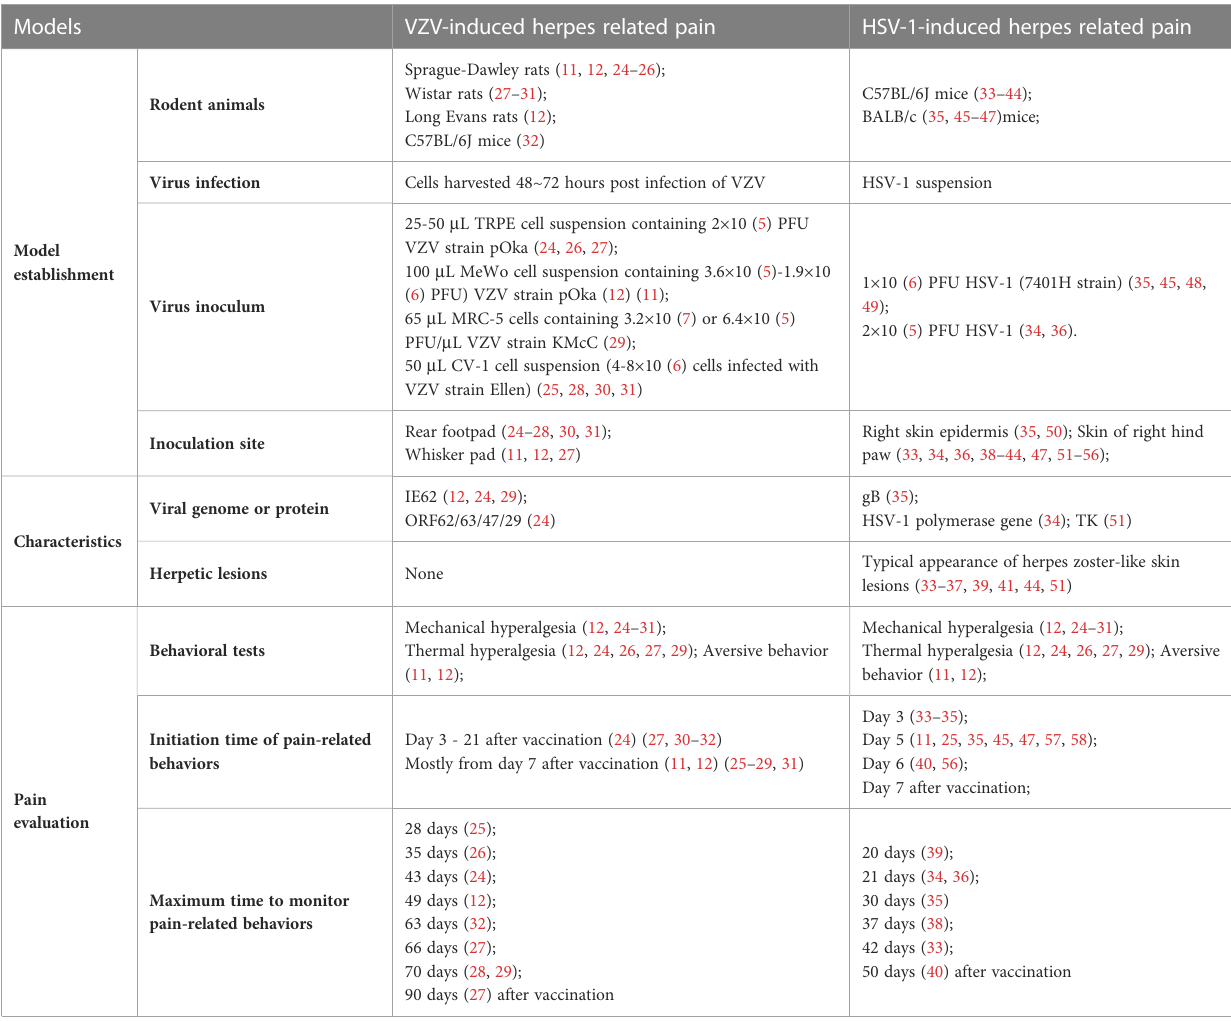
TABLE 1 PHN models and pain evaluation.